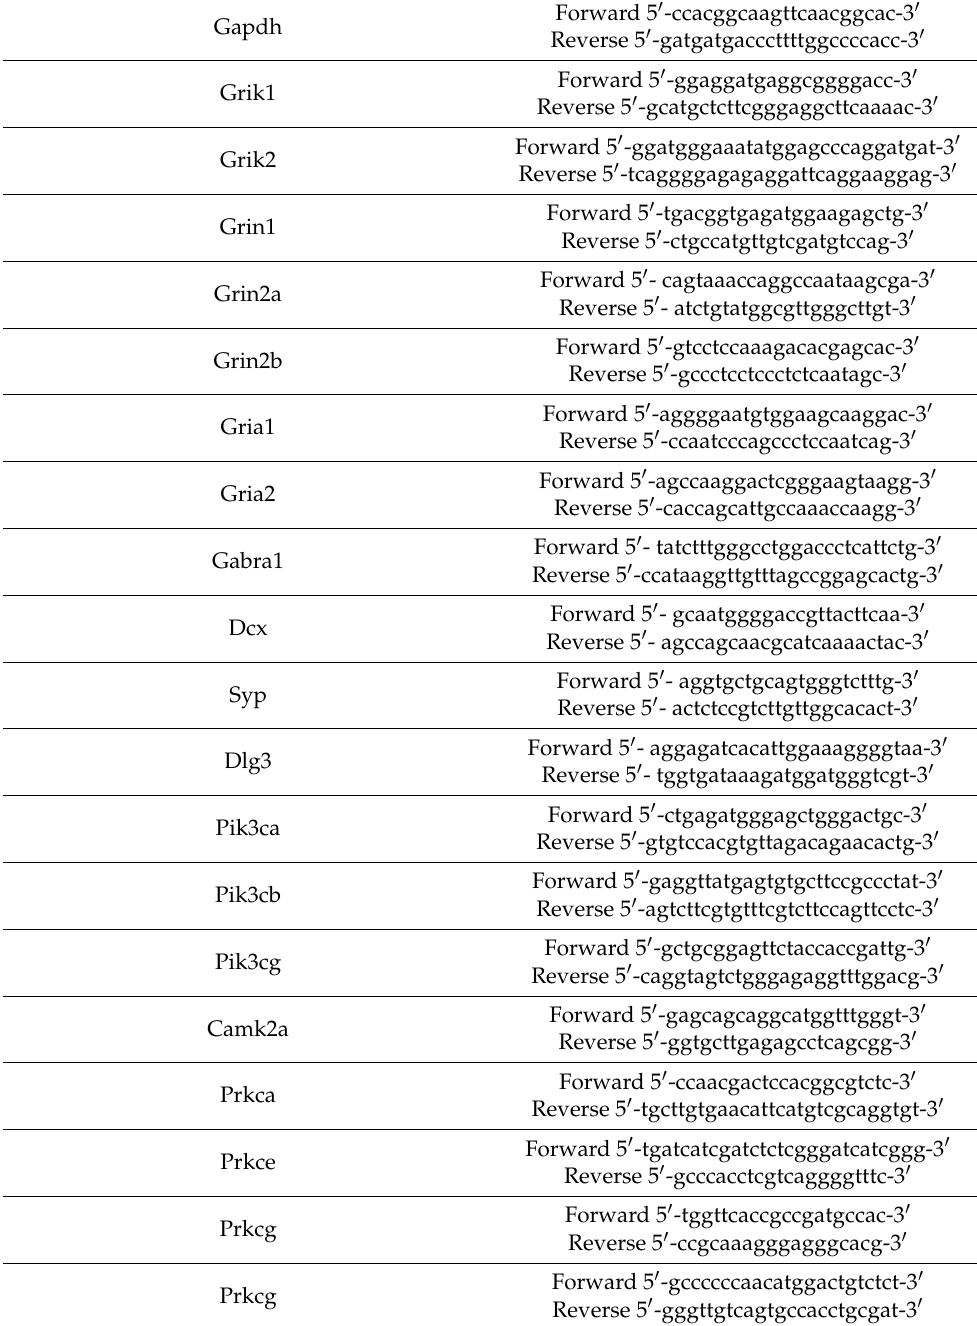
Table 1. Primer sequences for real-time polymerase chain reaction